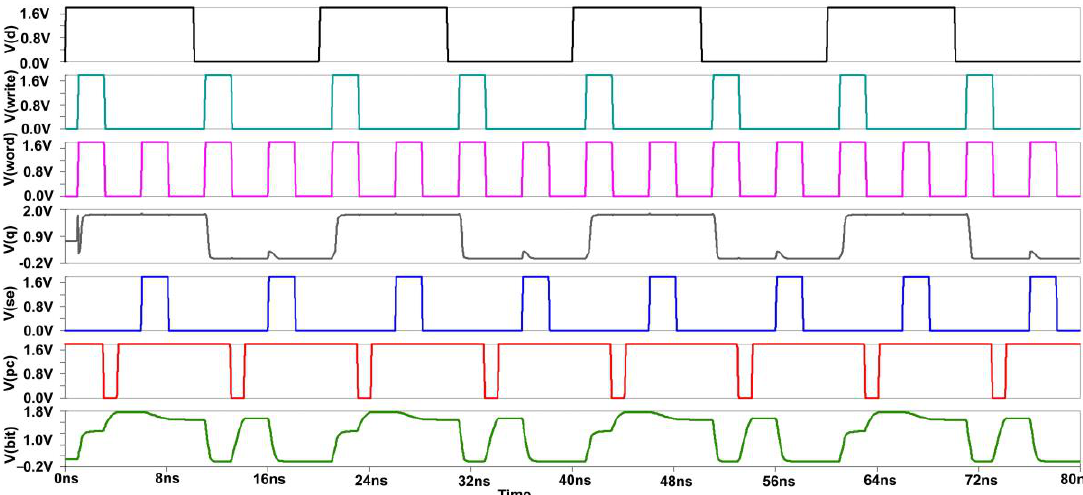
Figure 15. Output Waveform of Modified Basic Latch Sense Amplifier with Pass Transistor.